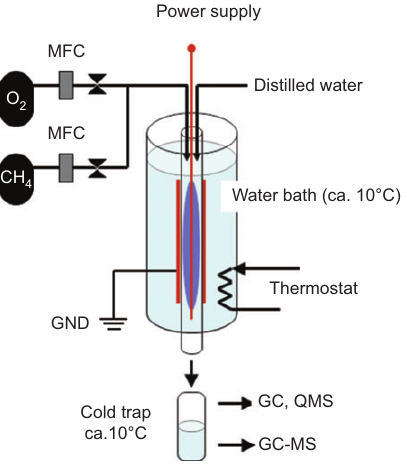
Figure 3 Schematic diagram of a micro-channel non-thermal plasma